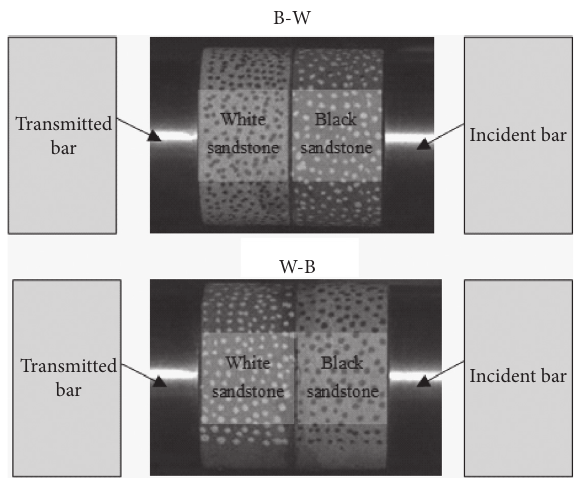
Figure 3: Schematic diagram of sample grouping.